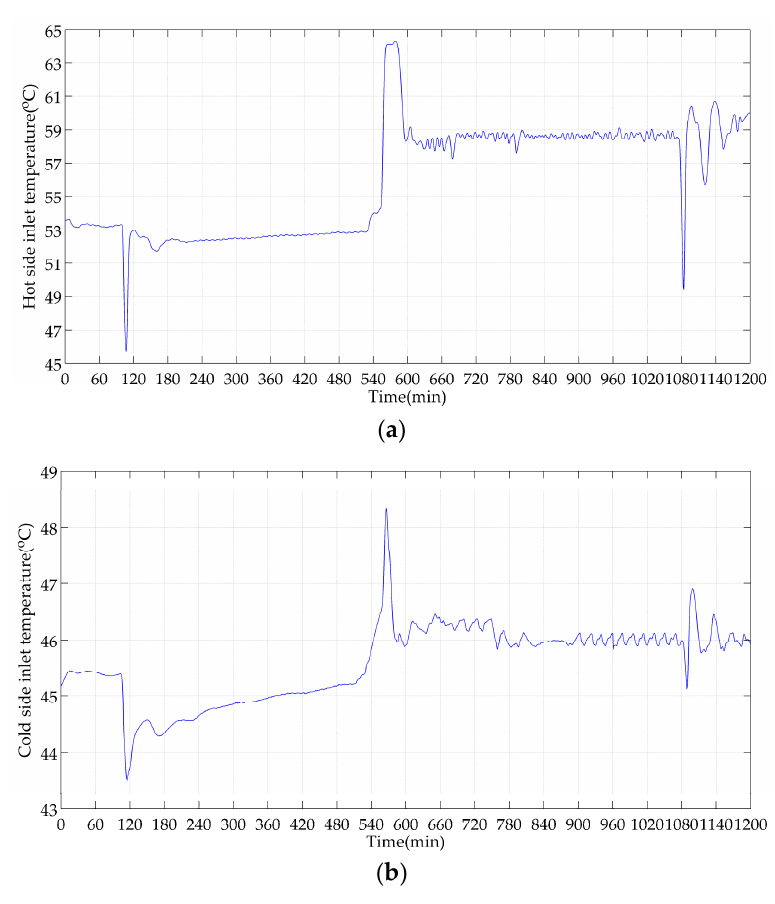
Figure 6. ( a ) Measurement results of ,1 h T ; ( b ) Measurement results of ,1 c T .